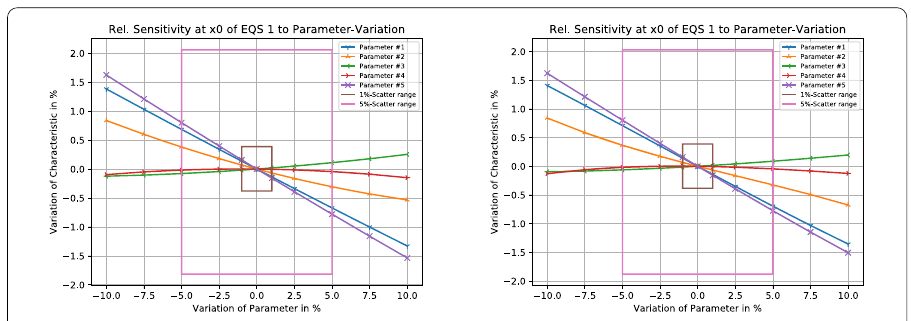
Fig. 18 Sensitivity for brakedisk sensitivity for F 1 of brakedisk(Poly=2 left, Poly=3 right)